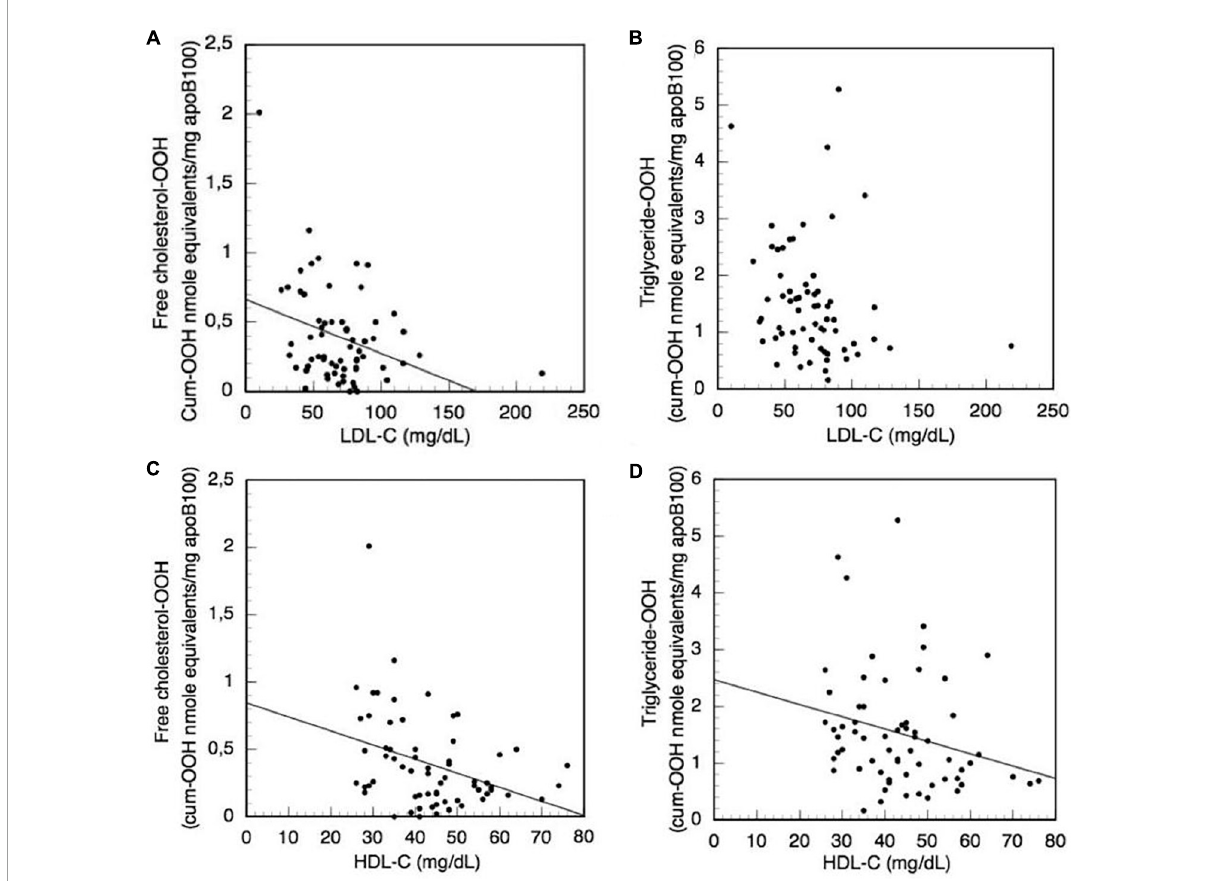
FIGURE7 Correlation of the clinical biochemical markers LDL-C and HDL-C with LDL triglyceride-OOH and free cholesterol-OOH levels in CKD-5d patients. (A) LDL-C with free cholesterol-OOH; (B) LDL-C with triglyceride-OOH; (C) HDL-C with free cholesterol-OOH; and (D) HDL-C with